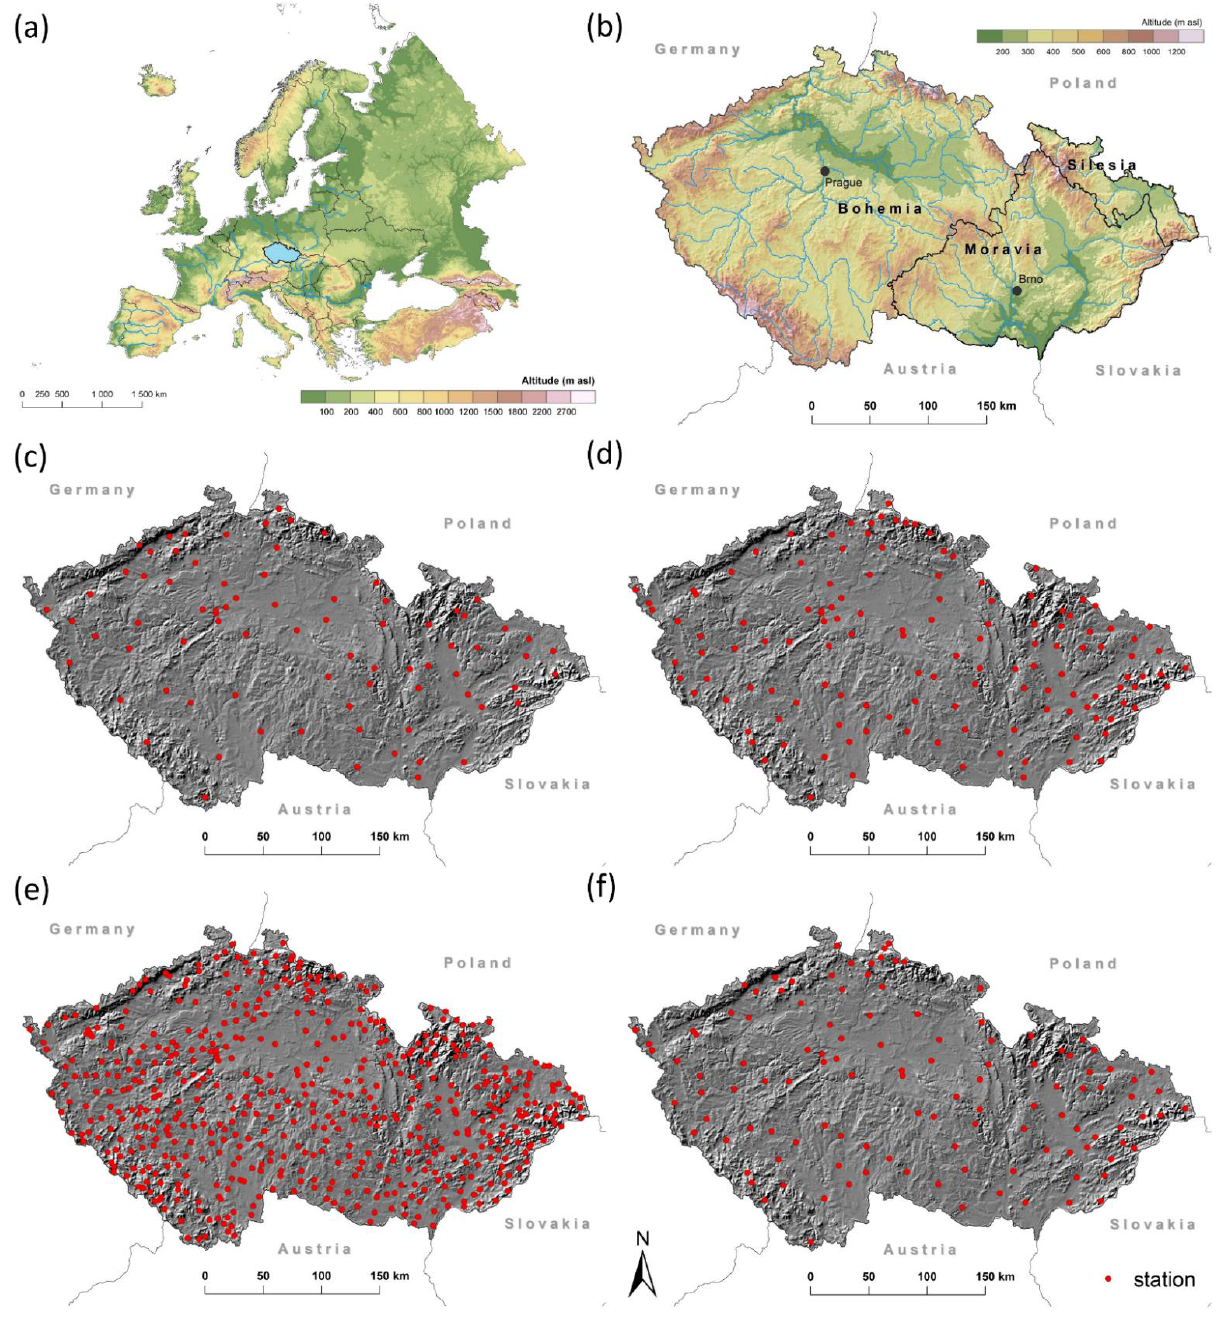
Figure 1. ( a ) The location of the Czech Republic in Europe, ( b ) the physical geographical map of the Czech Republic, and the network of meteorological stations of the Czech Hydrometeorological Institute used for the calculation of ( c ) sunshine duration, ( d ) temperatures and relative humidity, ( e ) precipitation totals, and ( f ) wind speed.